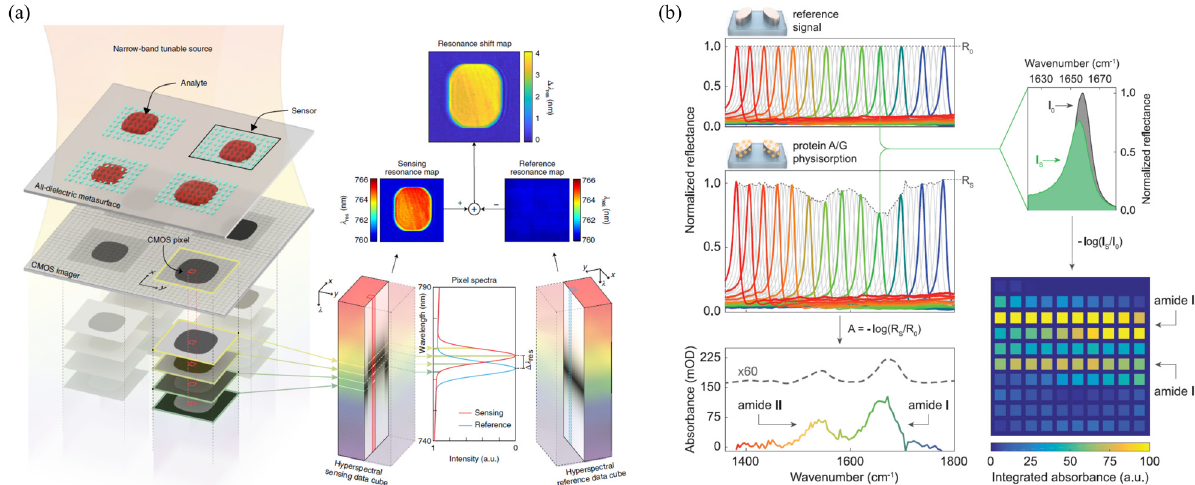
Figure12: Hyperspectralimaging-basedbiomoleculedetectionusingall-dielectricmetasurfacesandmolecularfingerprintretrievalbasedon spatial absorption mapping. (a) Sketch of the hyperspectral imaging principle showing a representative dielectric metasurface sensor array illuminated with a narrow-band tunable laser source. At each wavelength illumination, images are recorded by a CMOS camera to create a hyperspectral data cube where each CMOS pixel captures high-resolution spectral information. The hyperspectral data cube is processed to extract [57] spatial resonance maps of each individual sensor. For biomolecule detection, the sensing and reference resonance maps are combined to create the resonance shift map, which conveys spectral shift information across the whole sensor. (b) Normalized metapixel re fl ectance spectra before and after physisorption of a protein A/G monolayer. R0 indicates the envelope of peak re fl ectance amplitudes and RS is re fl ectance envelope RS. Protein absorption fi ngerprint calculated from the re fl ectance envelopes R0 and RS compared to an inde- pendent IRRAS measurement. Broadband spectrometerless operation of the metasurface can be emulated by integrating the re fl ectance signal of all pixels. Spectral integration translates the absorption signature into a 2D spatial absorption map that represents the molecular barcodeoftheprotein.(a)isreprintedwithpermissionfromRef.[58],copyright2019NaturePublishingGroup;(b)isreprintedwithpermission from Ref. [57], copyright 2018